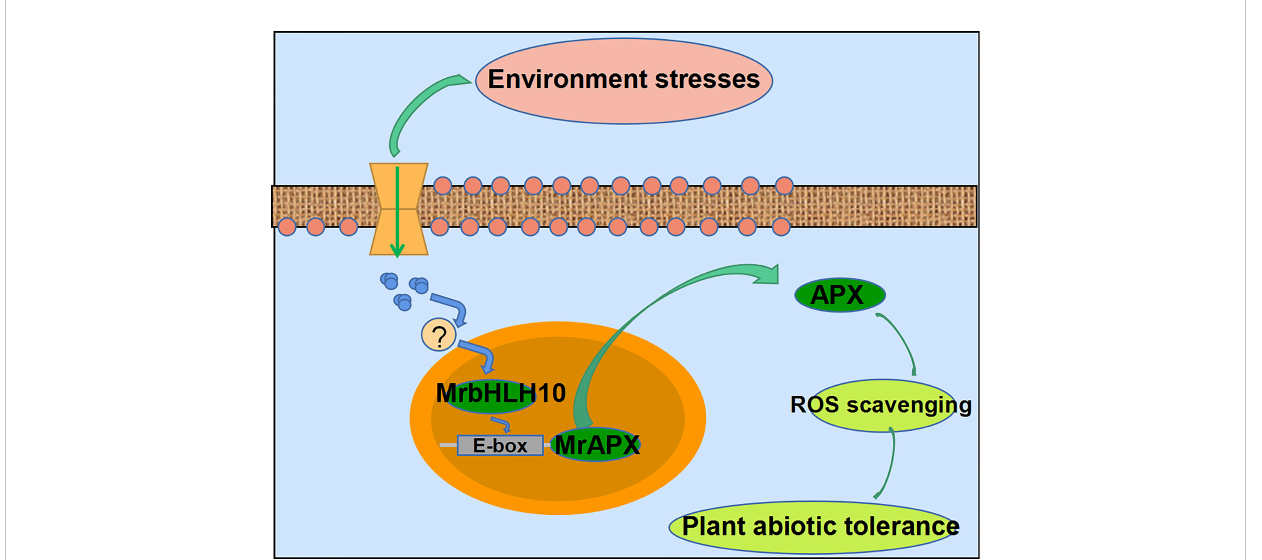
FIGURE 7 A potential working model for bHLH10 response to abiotic stresses in M. rubra . Under drought and cold stress, activating the environmental stresses signaling pathway and stimulating downstream stress signal transduction in plant cells, the upregulated bHLH10 acts upstream of APX and directly regulates its expression by binding to the E-box motif of its promoter. The activated APX then promotes cytosolic ascorbate peroxidase accumulation to scavenge ROS content under environmental